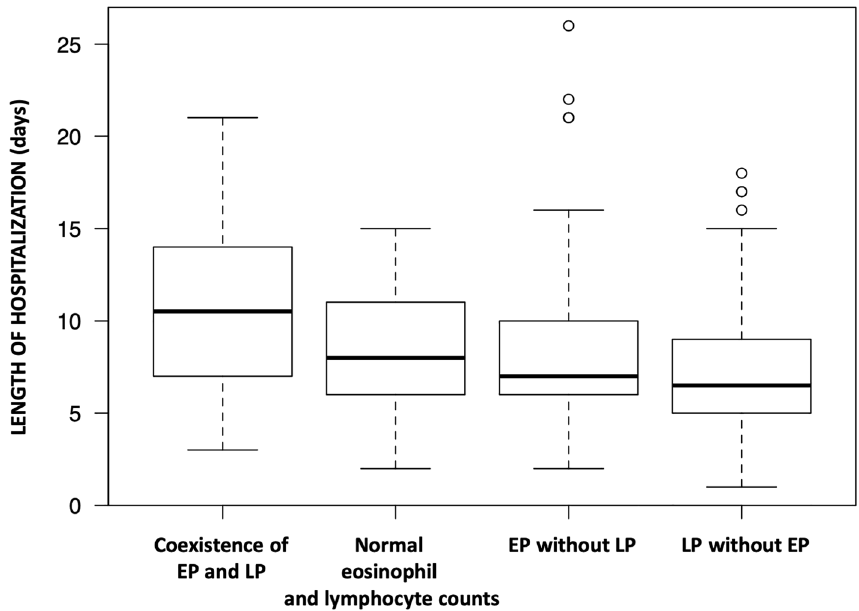
Figure 2. Boxplot for the comparison of length of hospitalization upon stratification by the presence of eosinopenia and lymphocytopenia coexistence. EP eosinopenia, LP